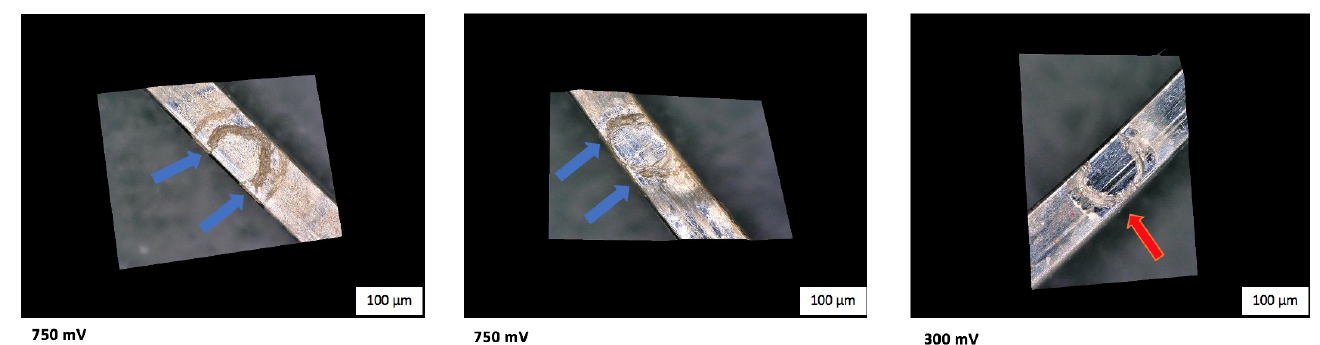
Figure 15. A number of 3D microscopic pictures of the SS wire surfaces after polarization in Ringer’s solution pH = 1 at RT. The applied potential is provided underneath each image; some areas of pitting corrosion are shown in red; some areas of crevice corrosion are shown in blue.